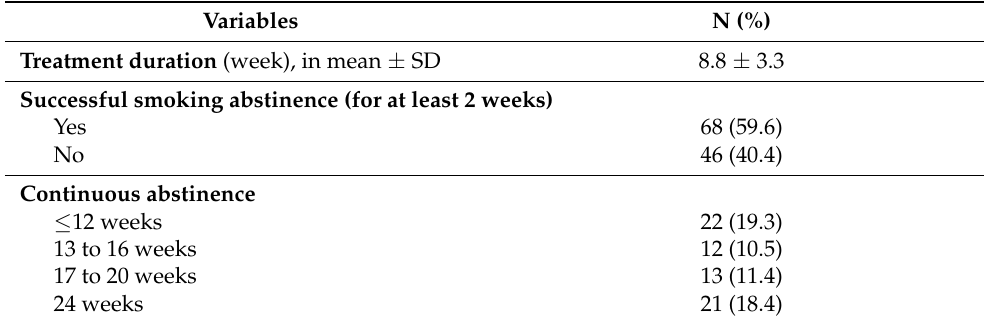
Table 3. Smoking abstinence and continuous abstinence among varenicline users. (N = 114).